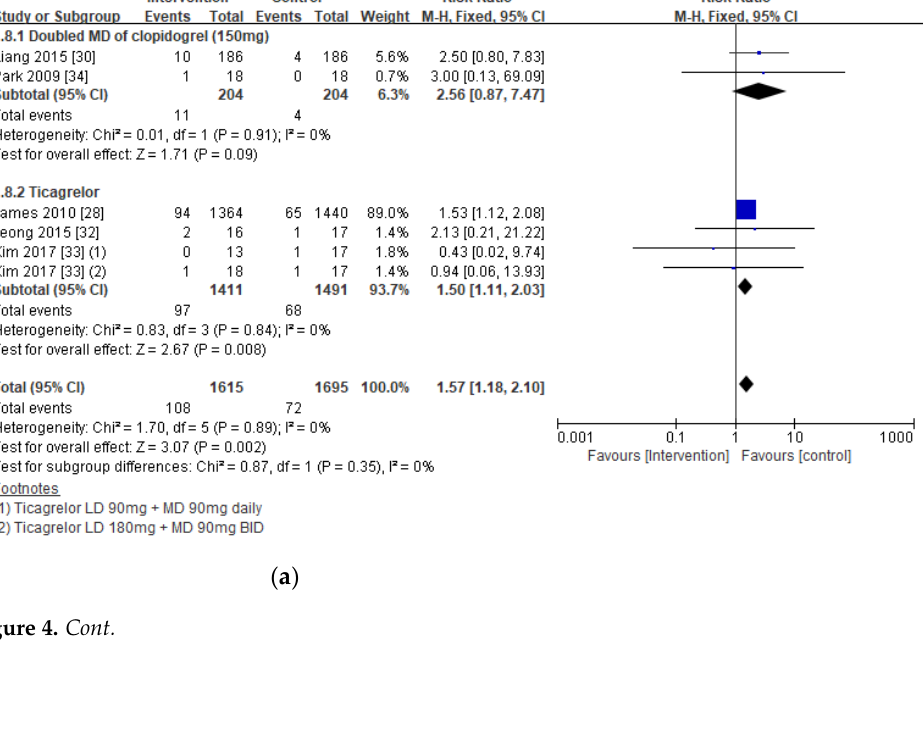
Figure 3. Forest plots of clinical outcomes in CKD patients from antiplatelet therapy: ( a ) major adverse cardiovascular events (MACE); ( b ) myocardial infarction (MI); ( c ) stent thrombosis; and ( d ) major bleeding risks. Blue indicates the risk ratio evaluated from each study and black indicates the overall risk ratio of the antiplatelet regimen.